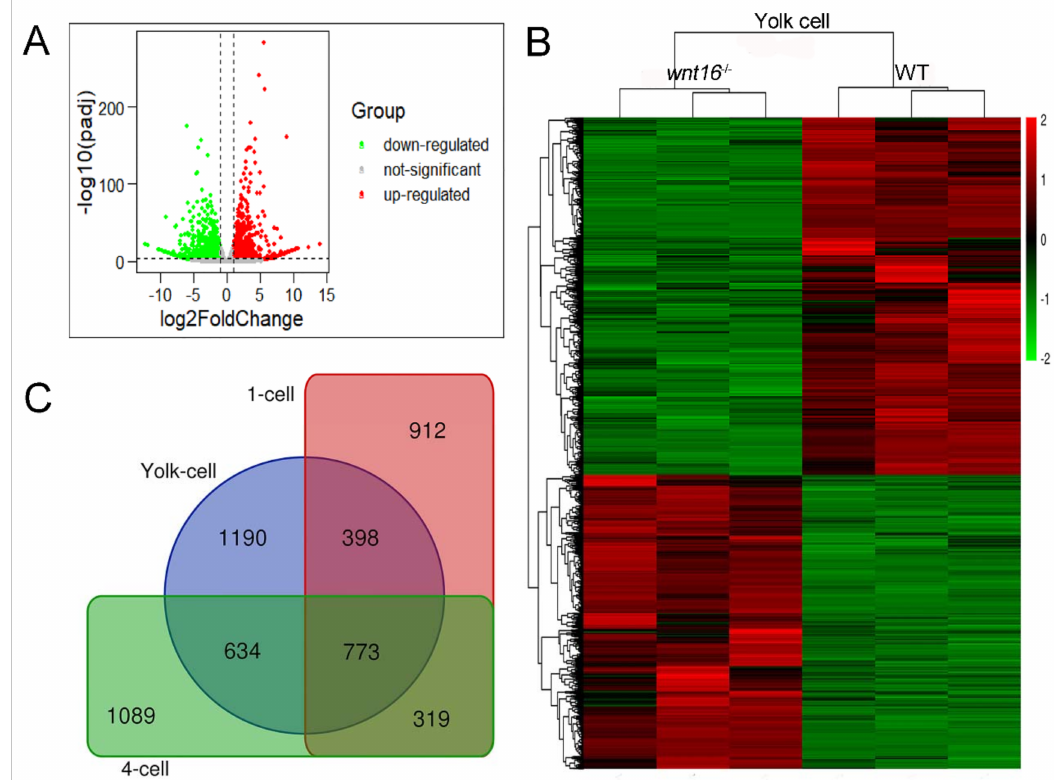
Figure 4. Clustering of differentially expressed genes (DEGs). ( A ) The volcano graph was performed to show DEGs in the yolk-cell period. The red part indicates up-regulated genes and the green part indicates down-regulated genes. ( B ) The overall distribution of DEGs between the WT group and wnt16 − / − group in the yolk-cell period. Red and green represent up-regulated and down-regulated changes, respectively, in the clustering analysis. The color intensity is directly proportional to the change. ( C ) Venn diagram of the co-expressed differential genes of three